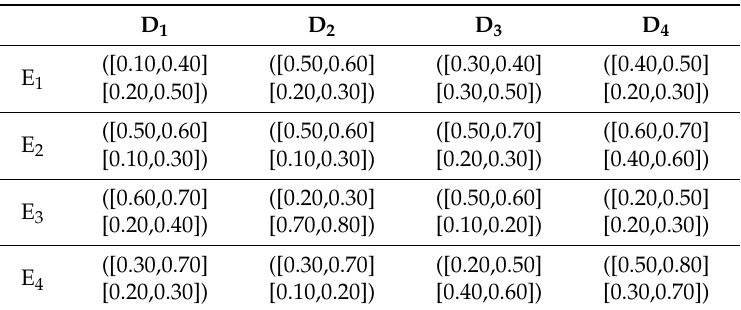
Table 1. Decision matrix.